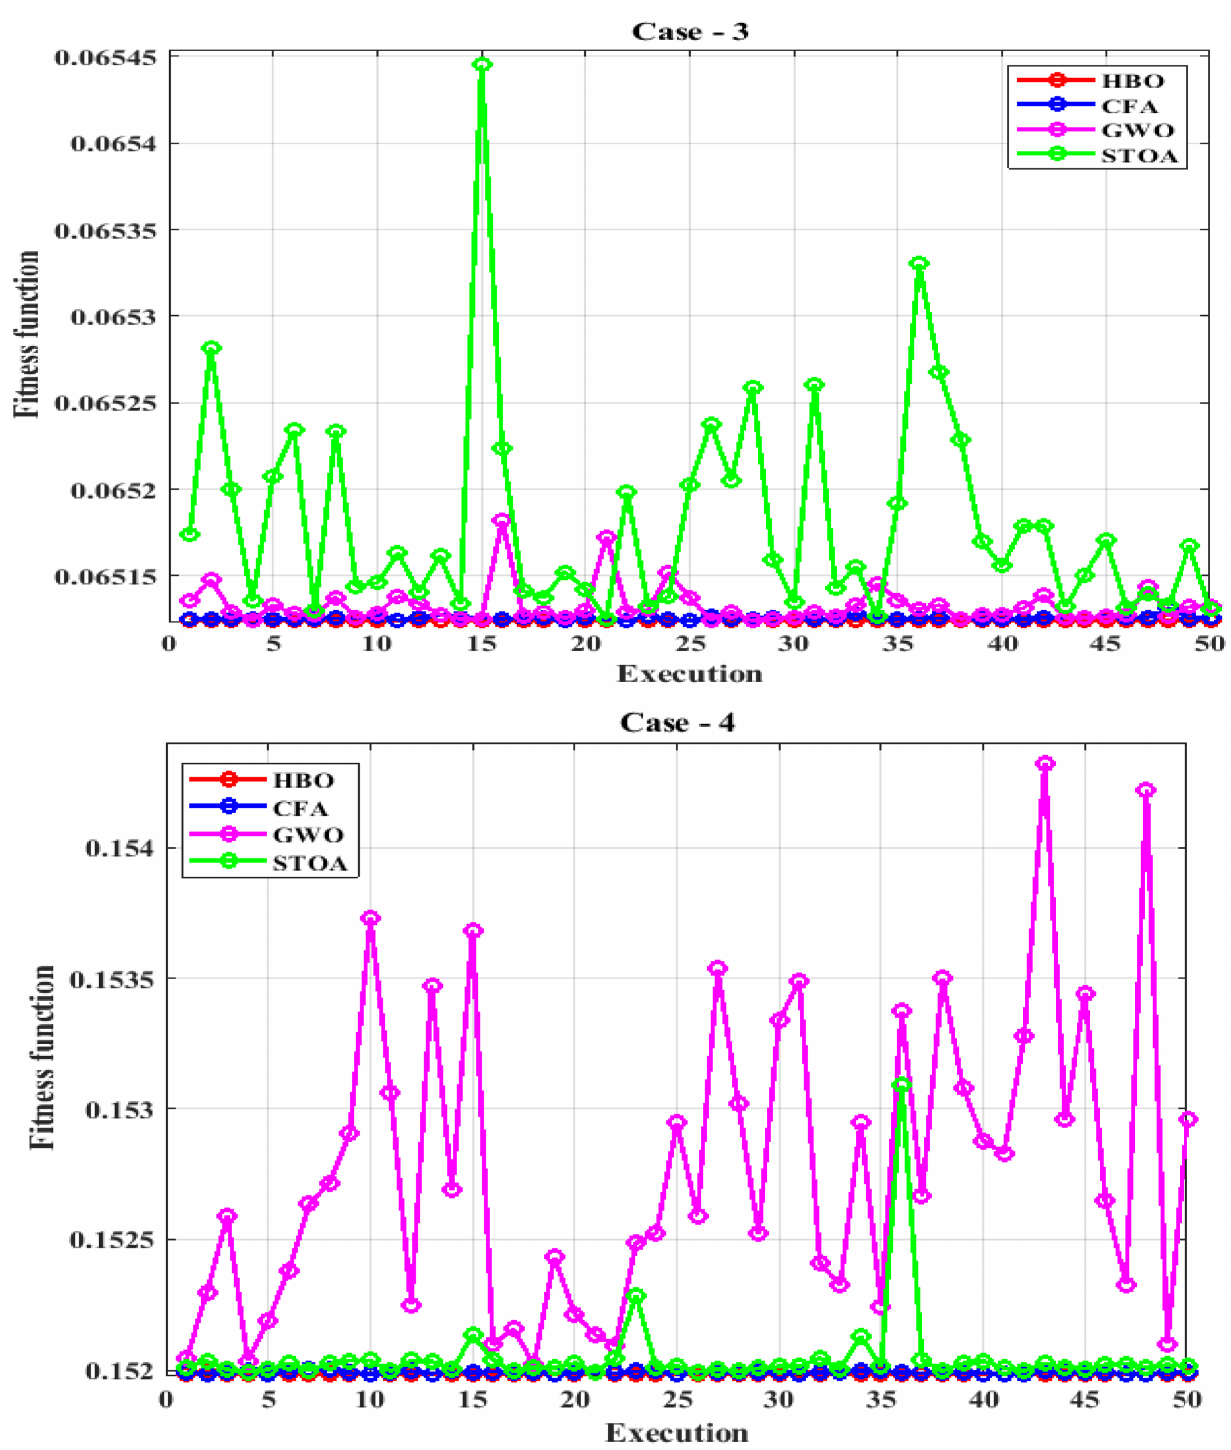
Figure 8. End values of the fitness function for 50 executions using HBO, CFA, GWO, and STOA methods: case-1: PV/WT/Biomass/Bat system, case-2: PV/Biomass/Bat system, case-3: WT/Biomass/Bat system, case-4: PV/WT/ Bat